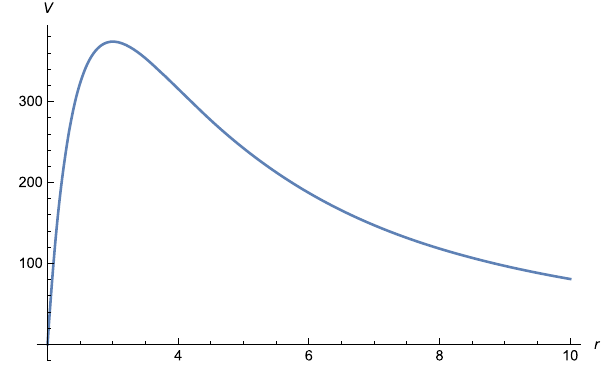
Fig. 1 An example of an effective potential: the Hayward BH in the eikonal regime ( (cid:2) = 100, α = 0 . 1) where r ∗ is the “tortoise coordinate”, mapping the event hori- zon to −∞ ,